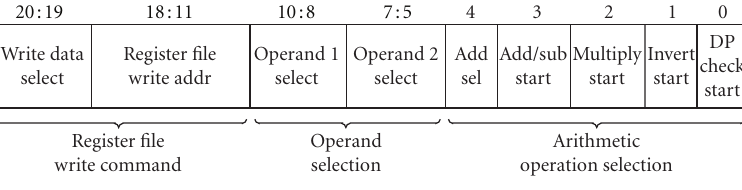
Figure 8: Microcoded instruction